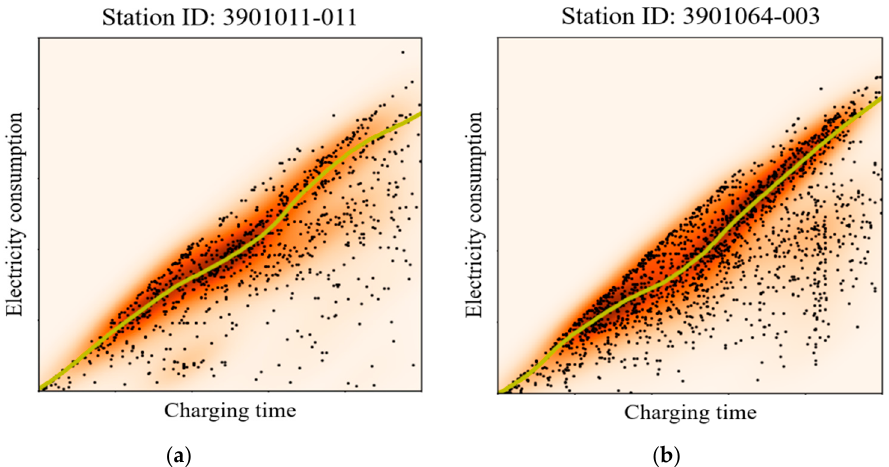
Figure 2. Heat maps related to the estimated probability function of electricity consumption distribution in a relation to charging time for sample stations. Station ID: ( a ) 3901011-011; ( b ) 3901064- 003.